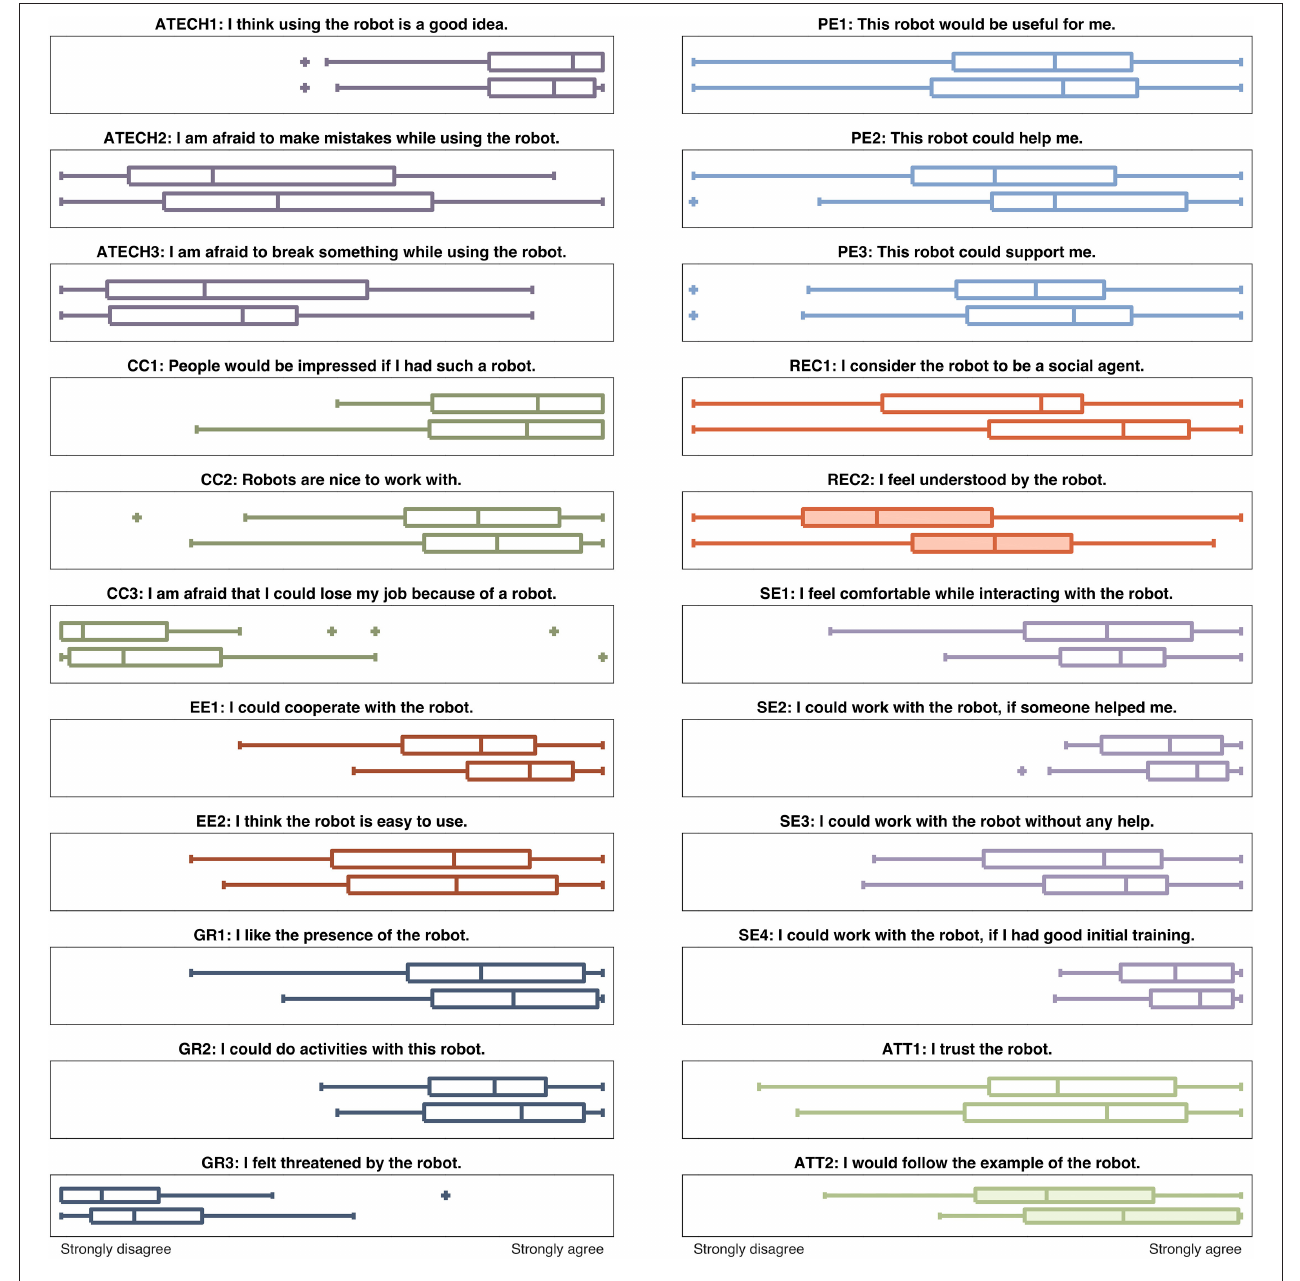
FIGURE 7 | Differences in participant responses before and after the human-robot hand-clapping experiment. In each subplot, the upper box plot represents pre-experiment responses and the lower box plot represents post-experiment impressions. Filled-in box plots indicate significant differences. The question coding abbreviations stand for attitude toward technology (ATECH), cultural context (CC), effort expectancy (EE), forms of grouping (GR), performance expectancy (PE), reciprocity (REC), self-efficacy from UTAUT model (SE), and attachment